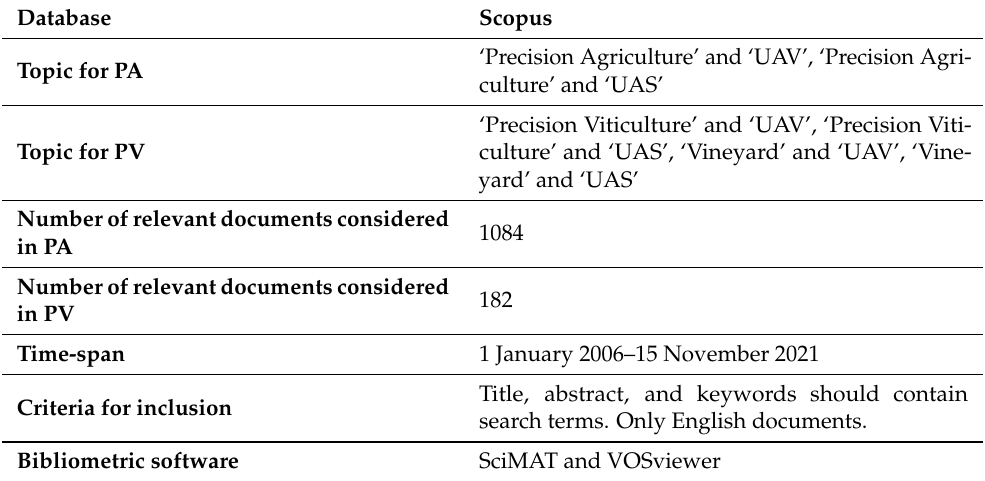
Table 1. Search strategy adopted to explore and retrieve relevant publications for the bibliometric analysis from Scopus